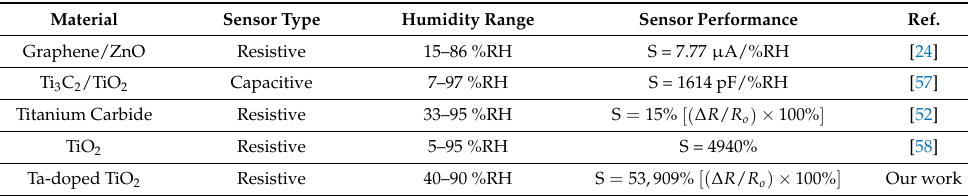
Figure 8. ( a ) Sensory response of TAFM at different Ta concentrations. ( b ) Effect of temperature on the sensor response of the TAFM-3. ( c ) Stability test using the TAFM-3 humidity sensor. ( d ) Sensor response of TAFM-3 toward the human breathing cycle. Table 3. Comparison of humidity sensor performance with other